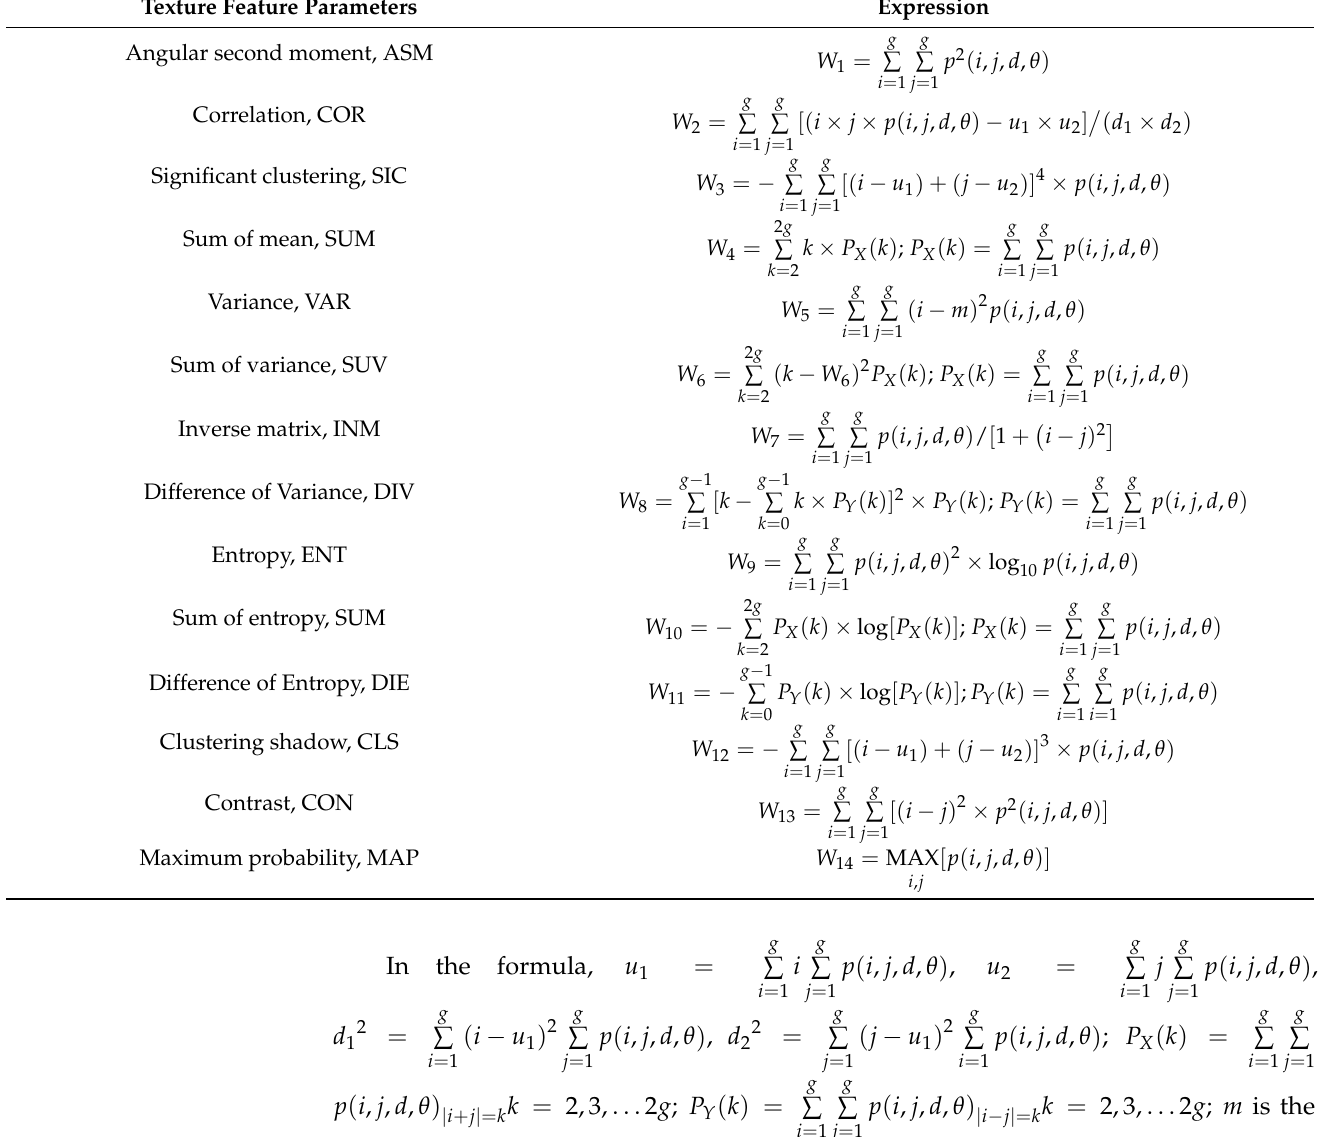
Table 1. The 14 characteristic parameters and their